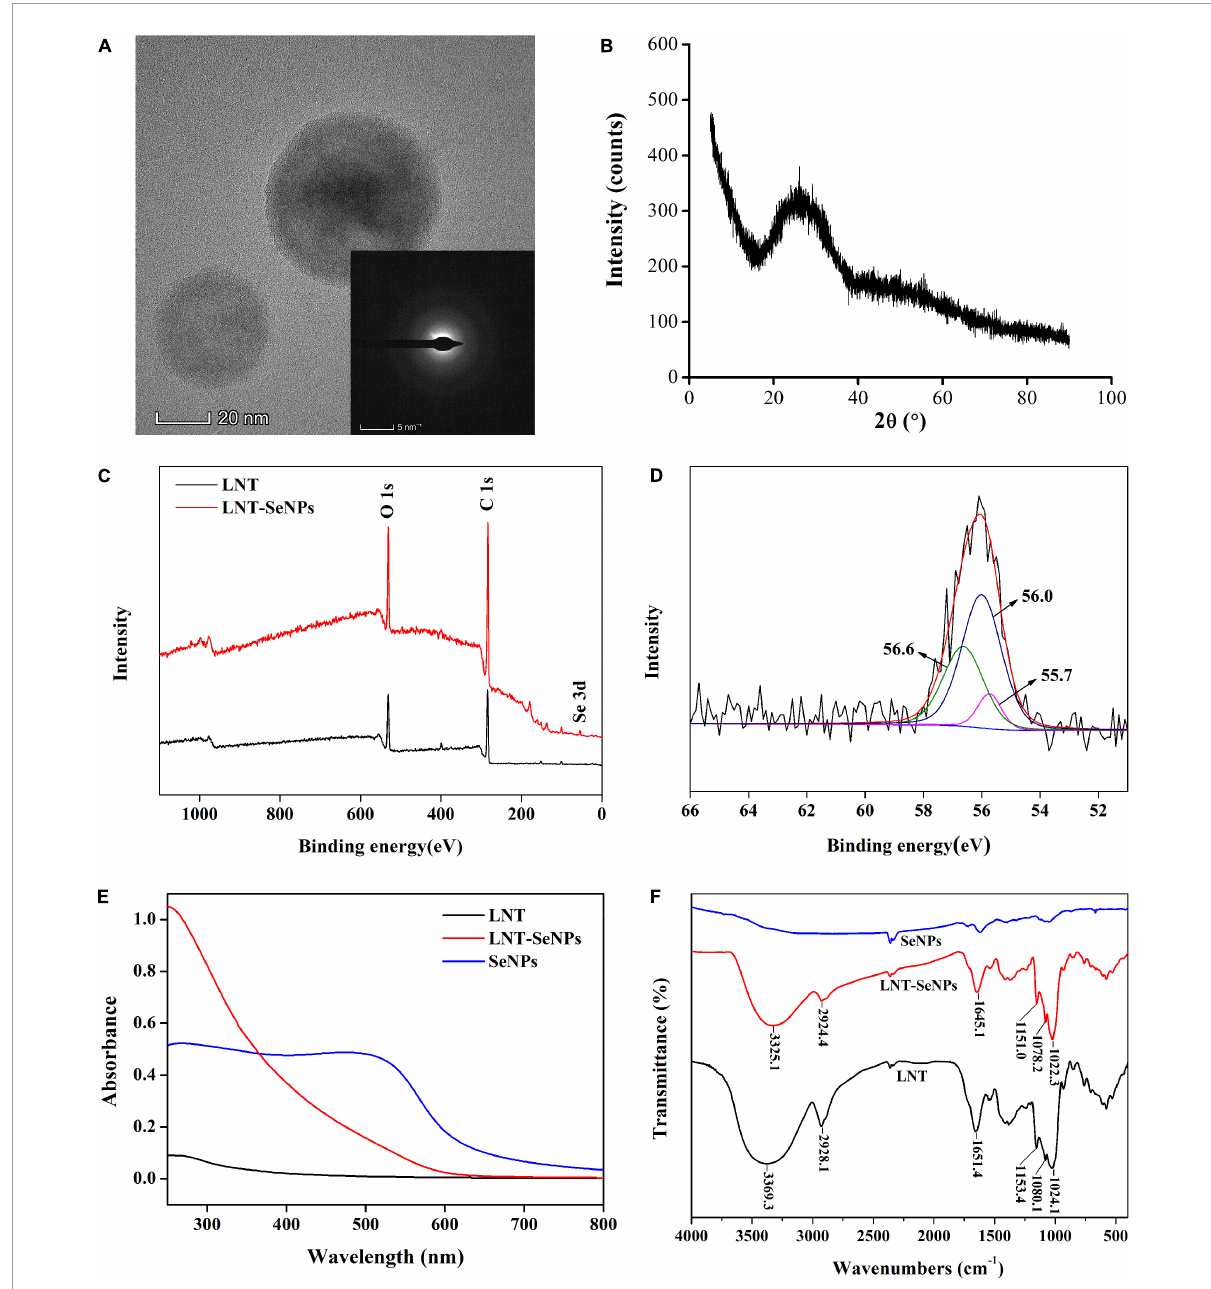
FIGURE2 The physicochemical characterization of LNT-SeNPs. HRTEM image of LNT-SeNPs and its corresponding SAED pattern (A) ; XRD pattern of LNT-SeNPs (B) ; wide-range XPS patterns of LNT and LNT-SeNPs (C) ; Se 3d spectra of LNT-SeNPs (D) ; UV–Vis spectra of LNT, LNT-SeNPs and SeNPs (E) ; FT-IR spectra of LNT, LNT-SeNPs and SeNPs (F)